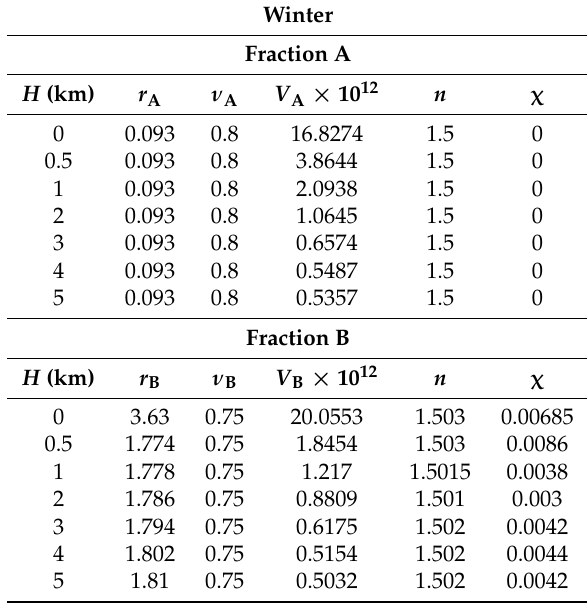
Table 1. Parameters of lognormal distributions of the submicron ( A ) and coarse ( B ) fractions.